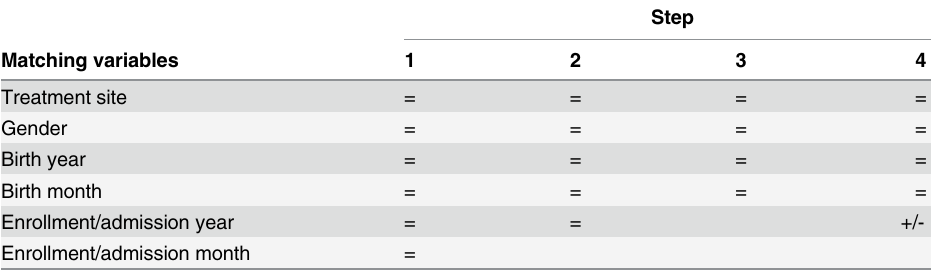
Table 2. The stepwise merge algorithm using indirect patient identifiers.